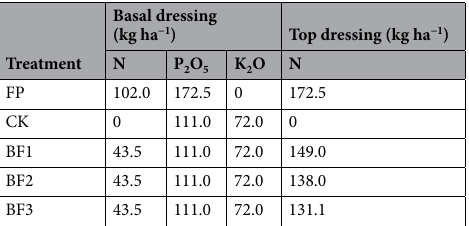
Table 1. Fertilization regimes of the different treatments in the 2019–2021 field